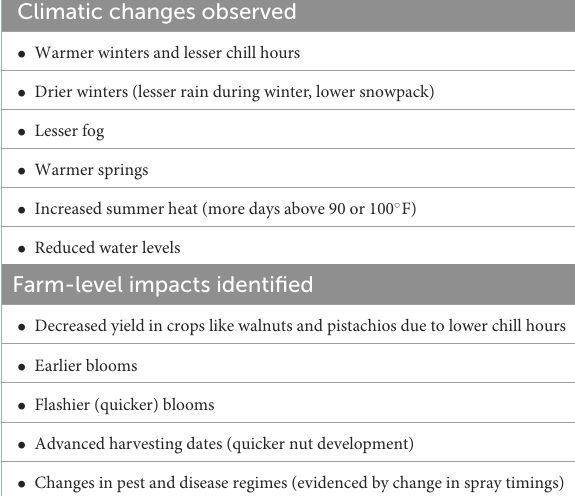
TABLE 1 List of climatic changes and farm-level climatic impacts observed by farmers and farm advisors. Climatic changes